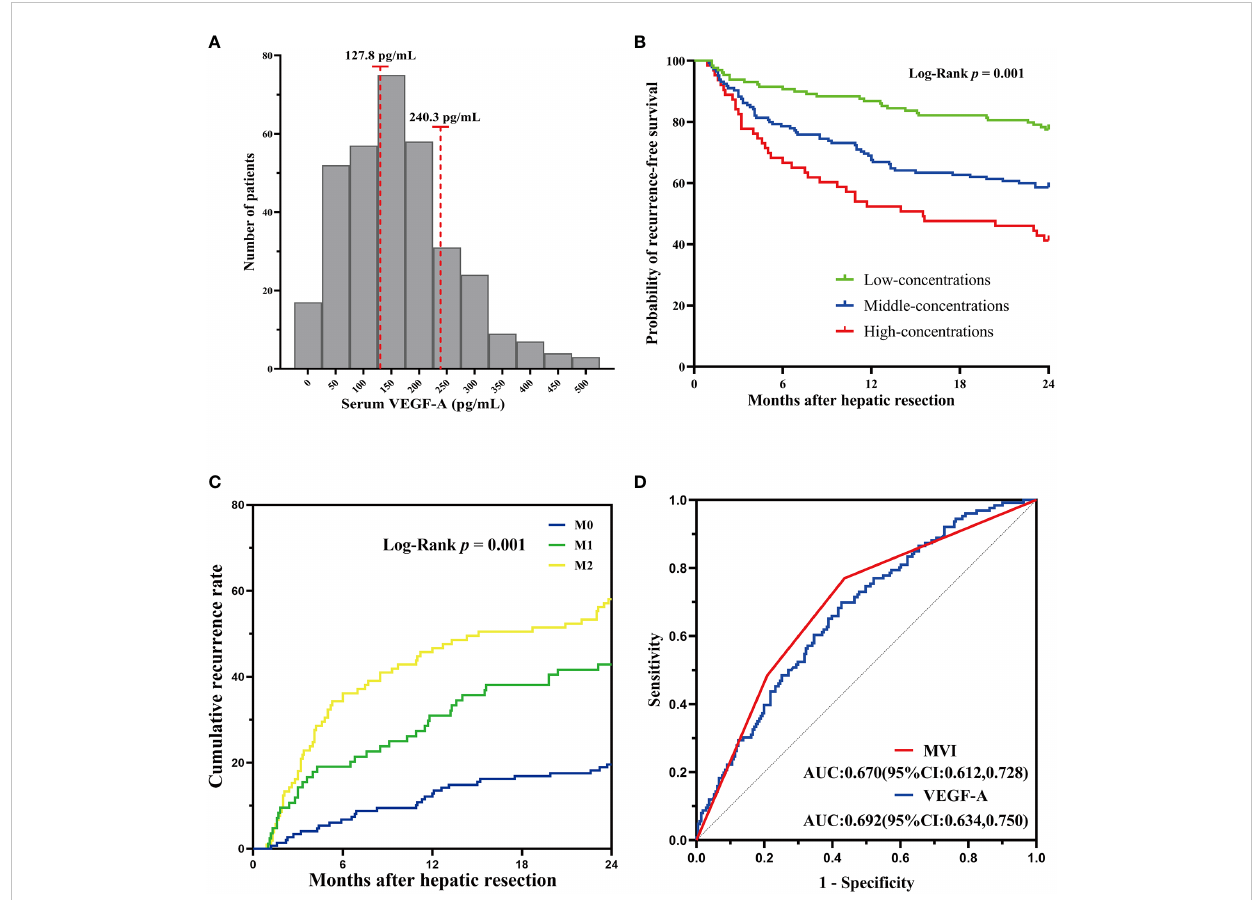
FIGURE 3 Serum VEGF-A and MVI correlated with HCC recurrence. (A) The cutoff value of VEGF-A concentrations was determined by the X-tile software. (B) Log-rank test for differences between low-, middle-, and high-concentrations groups shown signi fi cant differences. (C) The two-year cumulative recurrence rate among the three MVI subgrades. (D) ROC curves of MVI and VEGF-A for predicting early recurrence in HCC patients.